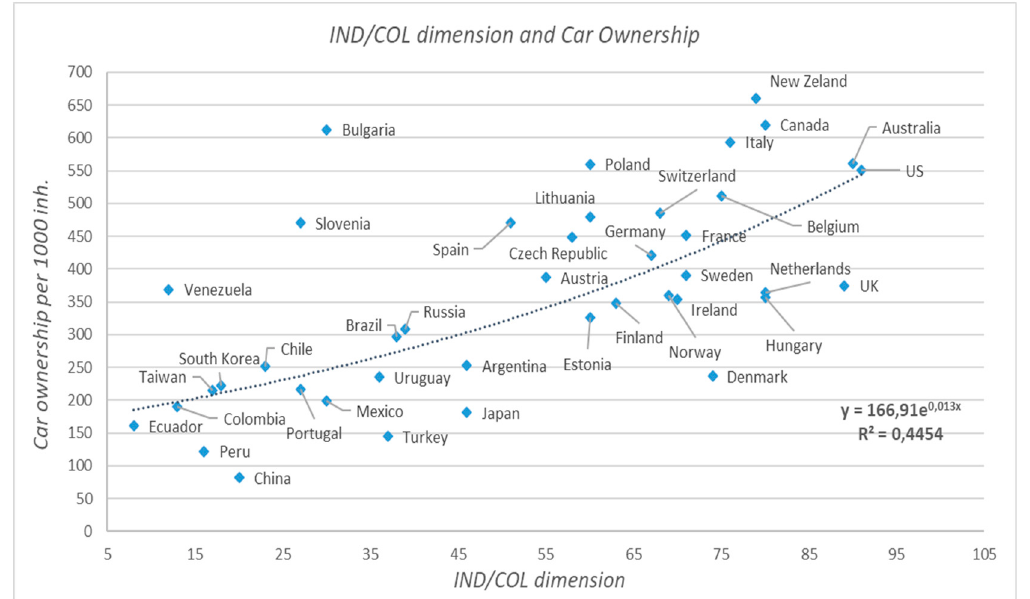
Figure 3. Road network accessibility over individualism-collectivism dimension. Soc. Sci. 2019 , 8 , x FOR PEER REVIEW